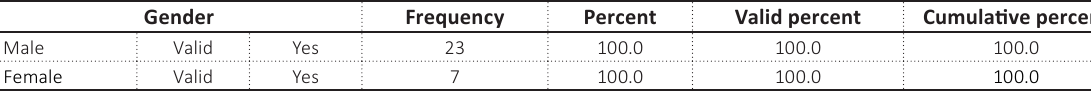
Table A6. Preserving and enhancing natural beauty in